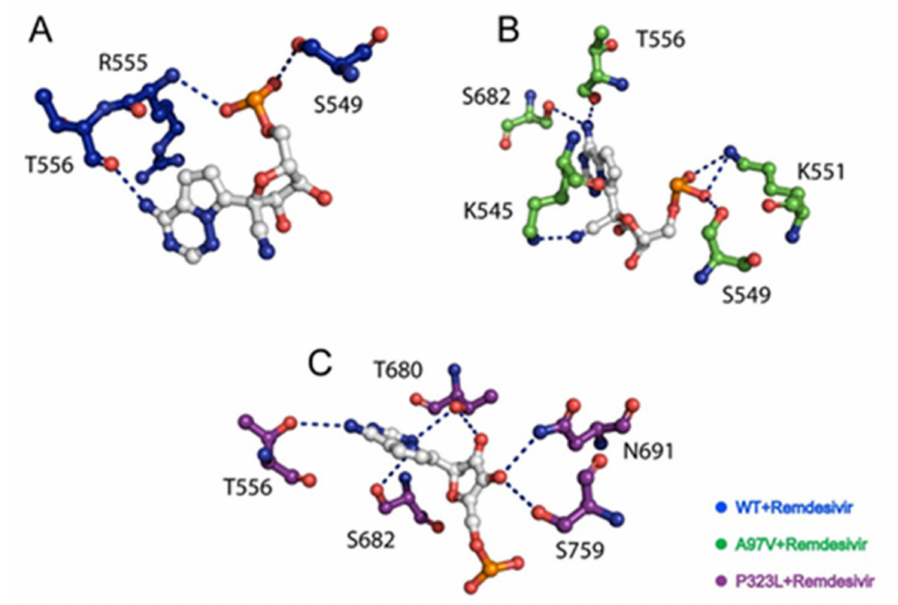
Figure 2. The H-bonding network or RDV interacting with RdRp residues in ( A ) WT, ( B ) A97V, and ( C ) P323L